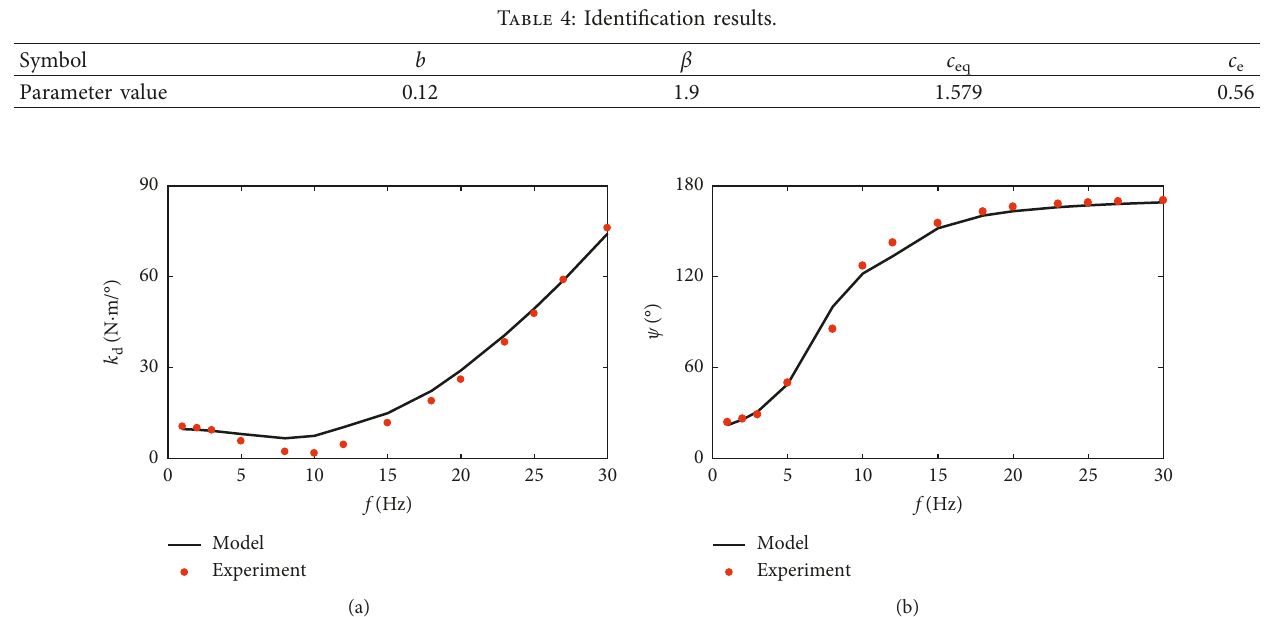
Figure 12: Excitation amplitude θ